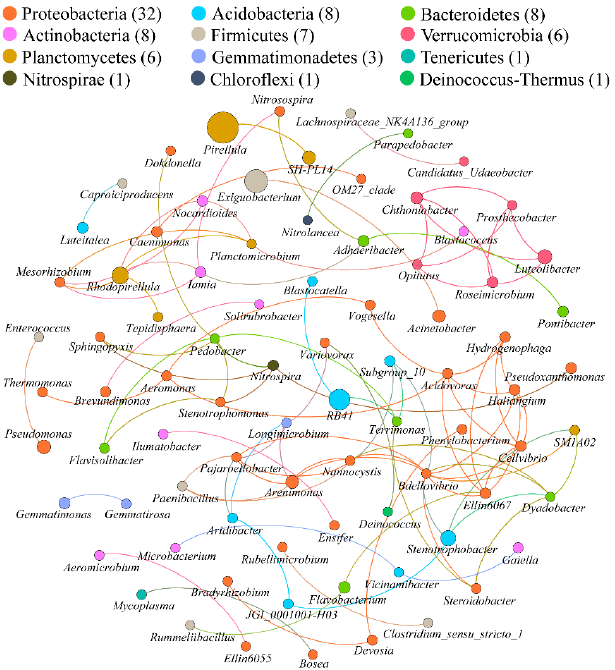
Figure 5. Network of co-occurring bacterial genera of nanoceria treatments based on Spearman cor- relation analysis sorted in color by phylum. A connection indicates a significant ( r > 0.6, p < 0.01) correlation. The size of each node (genus) is proportional to its abundance; the thickness of each connection between two nodes (edge) is proportional to the corresponding correlation coefficient.